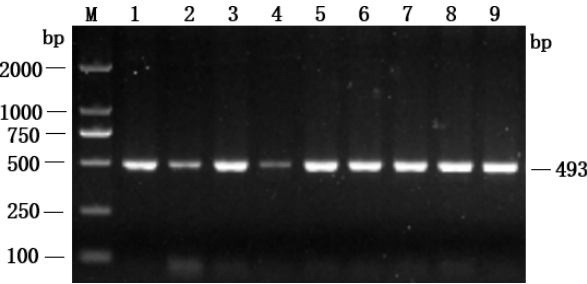
Figure B1. Detection of CLPG PCR products from three-way crossbred lambs (M, DL2000; 1–9, PCR products).